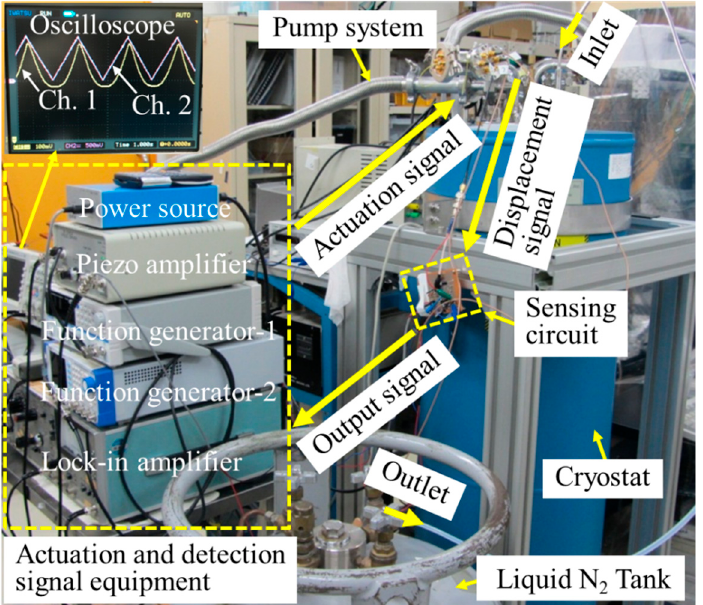
Figure 6. Experimental setup of the cryogenic measurement of the comb-drive actuators fabricated from a heterogeneous structure of Si bonded onto glass. (The inset shows the captured screen from the oscilloscope.).